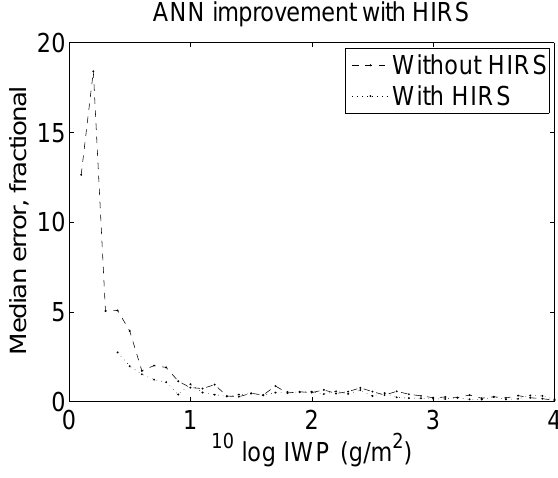
Fig. 10. Scatter plot showing the performance of the ANN using MHS channels 3 to 5. The retrieved IWP is plotted against the input IWP.